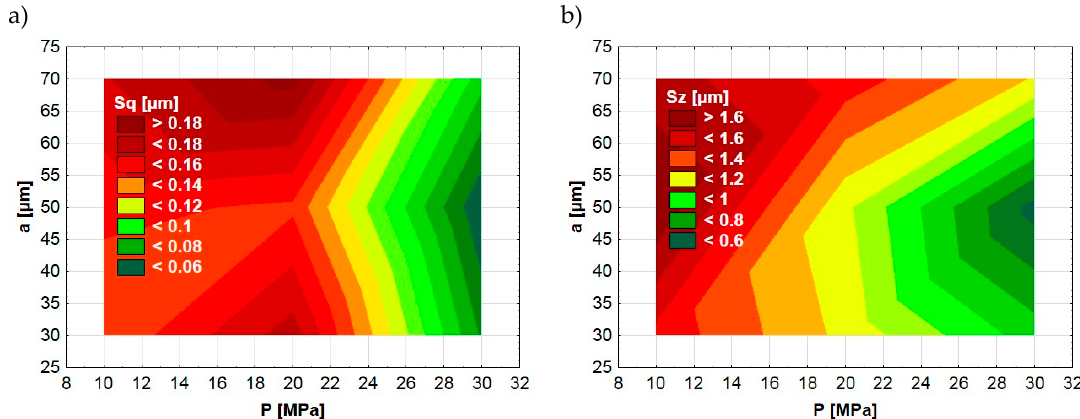
Figure 5. Dependence between ball-burnishing parameters ( P, a ) and surface topography parameters Sq ( a ), Sz ( b ).